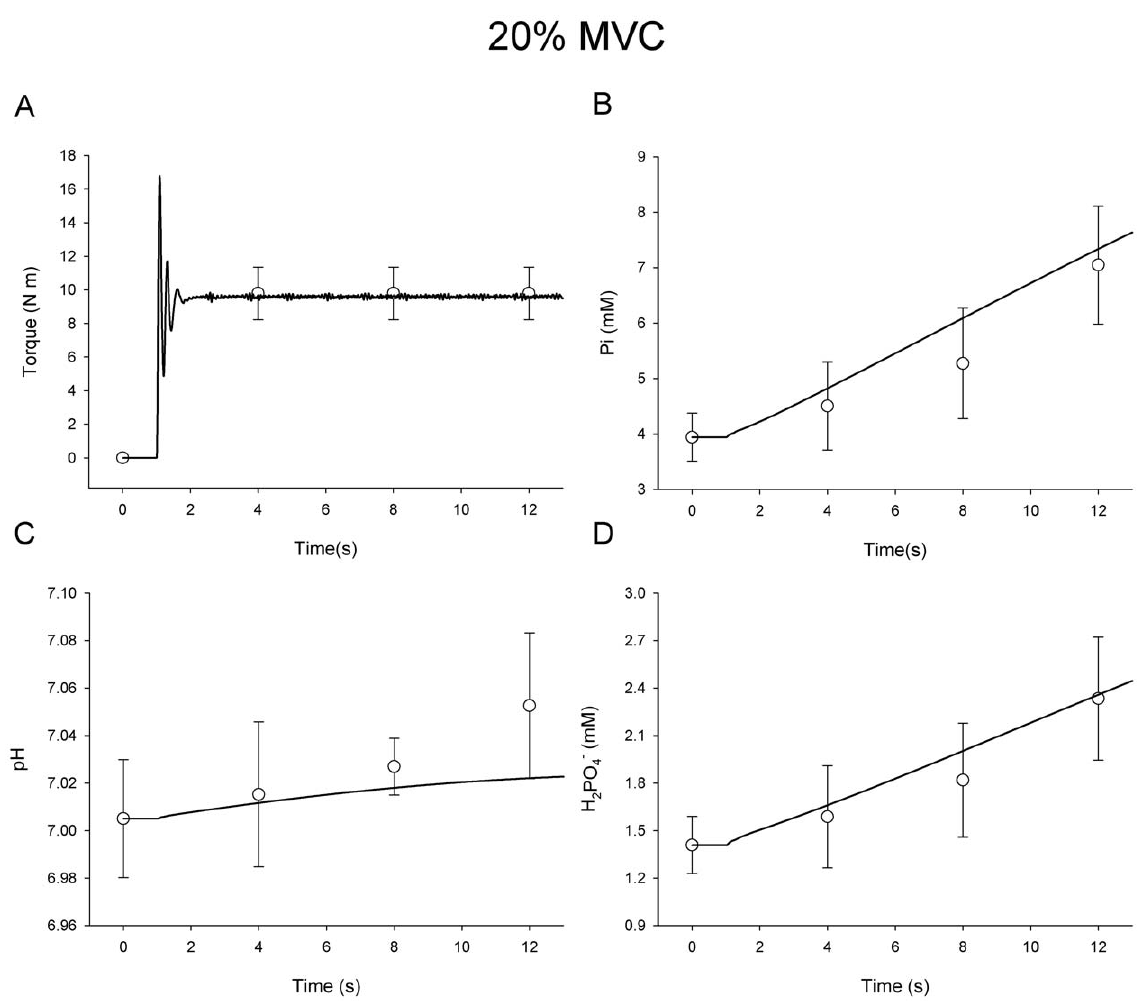
Figure 7. Simulated Submaximal Voluntary Contraction at 20% MVC. Simulated response of torque ( A ) inorganic phosphate ( B ), pH ( C ), and H 2 PO 4- ( D ) during 12-s contraction (black line). In vivo data (open symbols 6 SD) are shown for comparison.